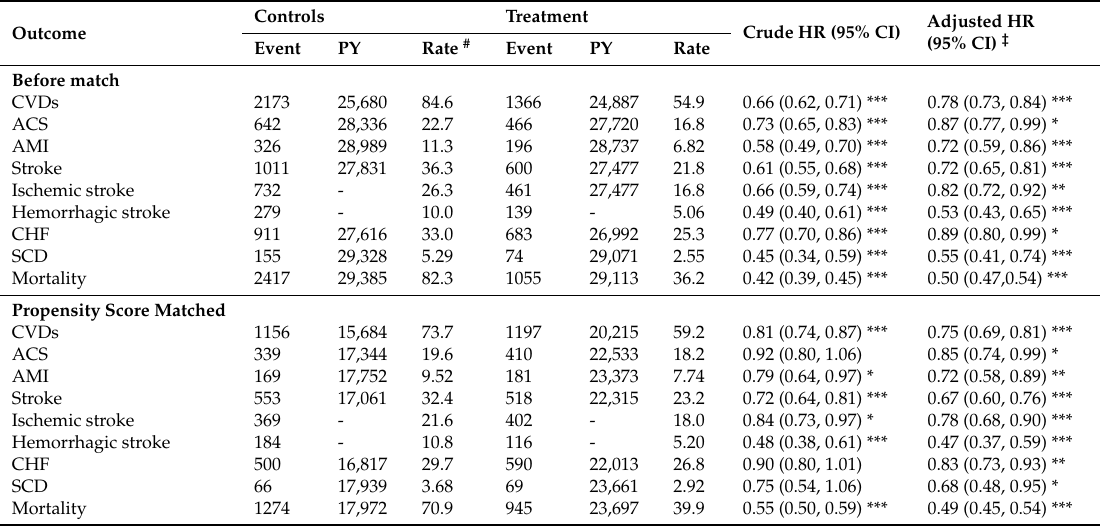
Table 2. Outcomes of periodontal disease (POD) treatment and control groups, determined using the matched Cox proportional hazard